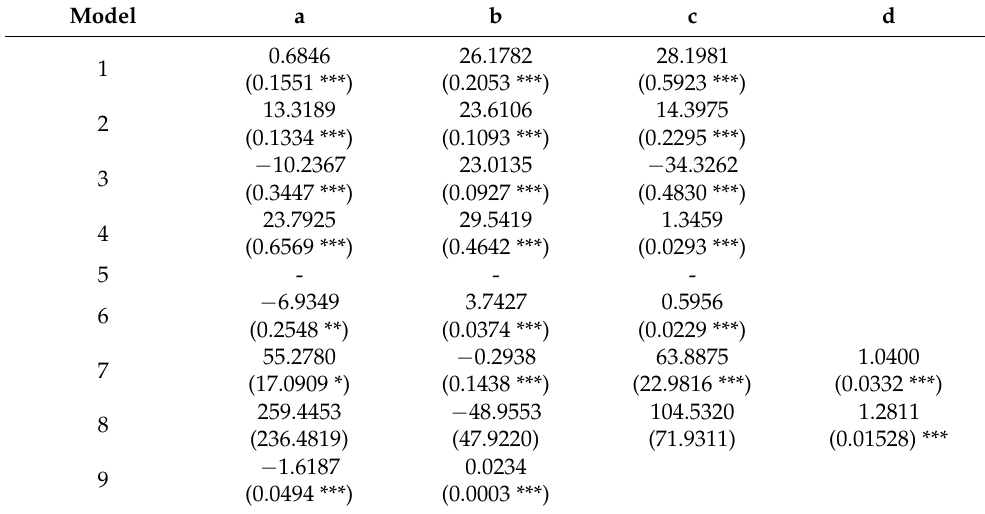
Table 4. Parameter estimation of nine candidate DH models (standard deviation) using modeling data.